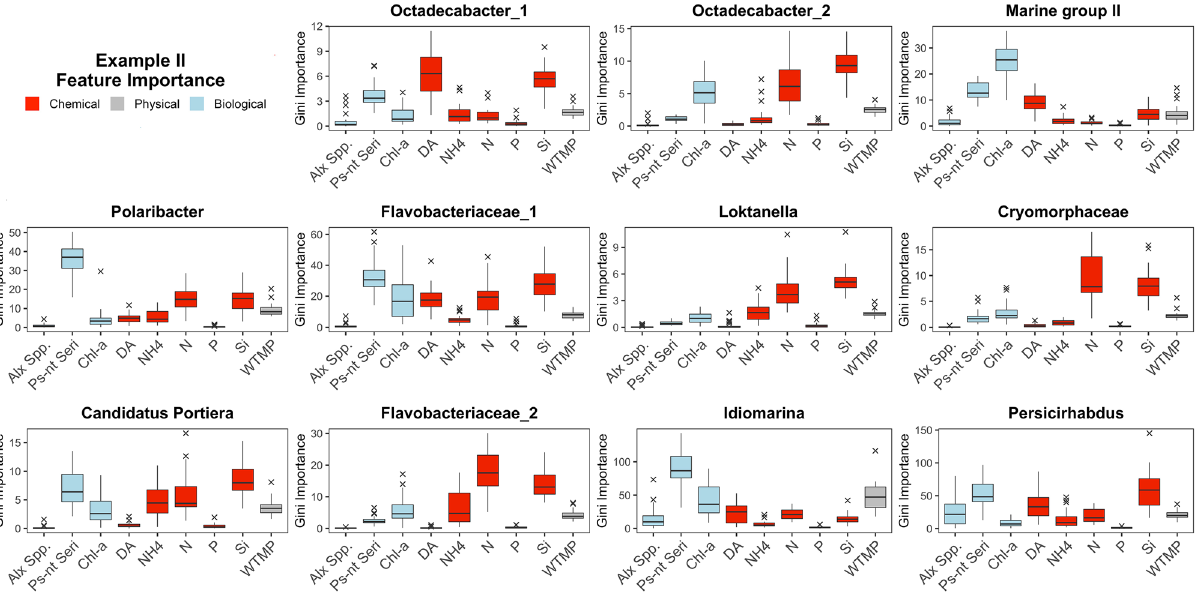
biological. Biotic (environmental) ocean measures consisted of ammonium (NH 4 , µM), silicic acid (Si, µM), nitrate (N, µM), phosphate (P, µM), temperature (WTMP, °C), and Domoic Acid (DA, mg/L). Biotic measures include Alexandrium spp . (Alx. Spp. cells/L), Pseudo-nitzschia in the size range of the functional group seriata , (Ps-nt. Seri. cells/L), and chlorophyll- a (Chl-a. mg/m 3 ) as a